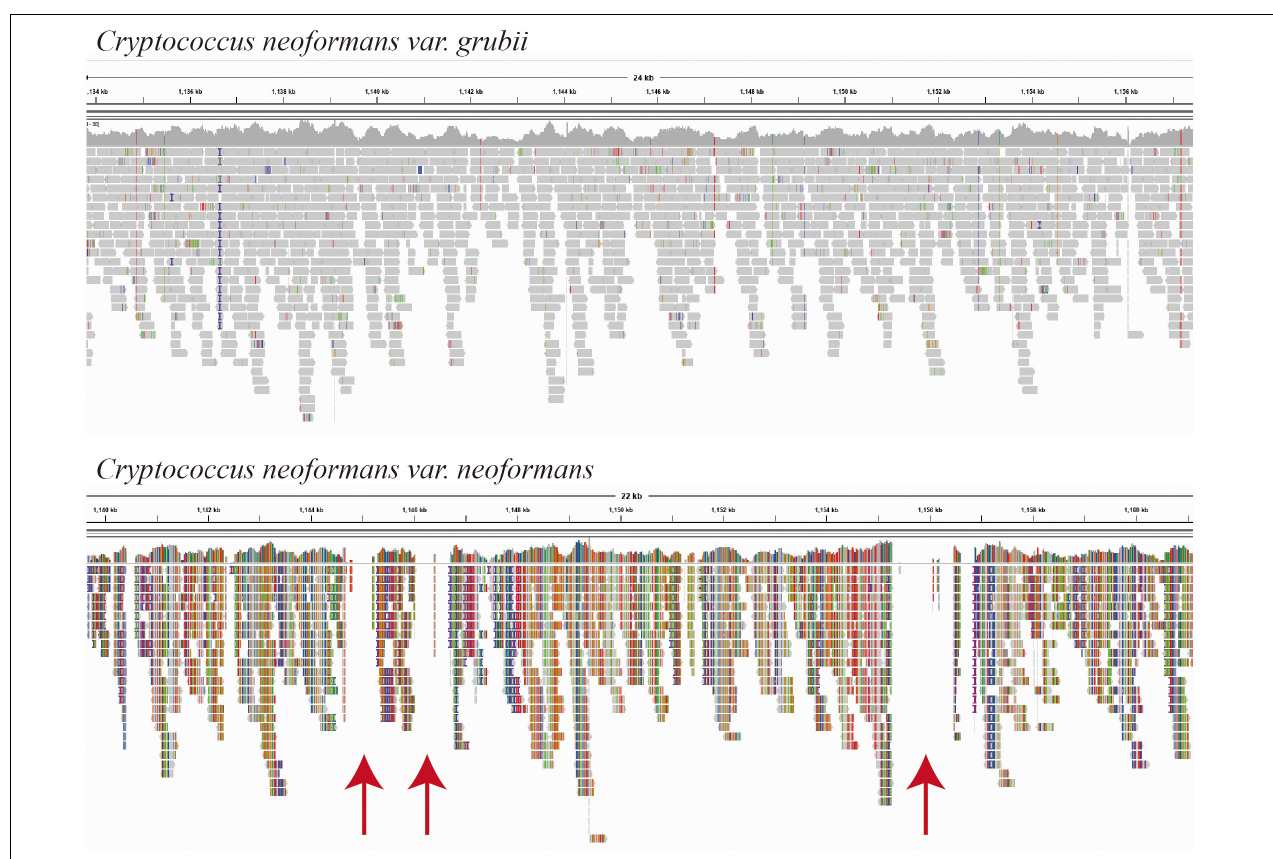
FIGURE 1 | Mapping of isolate C2 sequence reads as visualized by the Integrative Genomics Viewer (IGV) version 2.8.2 (Broad Institute, Cambridge, MA, United States). Sequence reads of isolate C2 were mapped using BWA-MEM, which maps medium and long reads ( > 100 bp). Reference-guided mapping was performed using chromosome 1 of each Cryptococcus neoformans variety (accession numbers NC_006670.1 and CP022321.1, respectively) as a reference genome. Mapping was performed using BWA-MEM (Galaxy Version 0.7.17.1), and BAM files were visualized by the IGV, which show even template coverage in the case of Cryptococcus neoformans var. grubii , while in the case of Cryptococcus neoformans var. neoformans you see clear gabs in the template coverage indicated by red arrows.